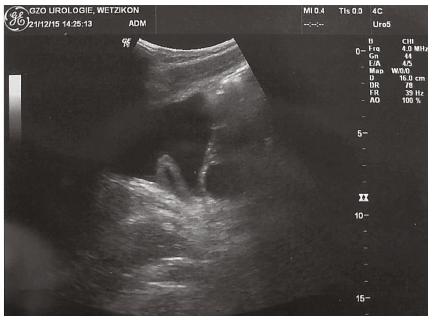
Figure5:Sagittalsectionofthesonographiccontrolatthe12-month follow-up. The ureterocele has significantly downsized compared to the initial CT scan (Figure